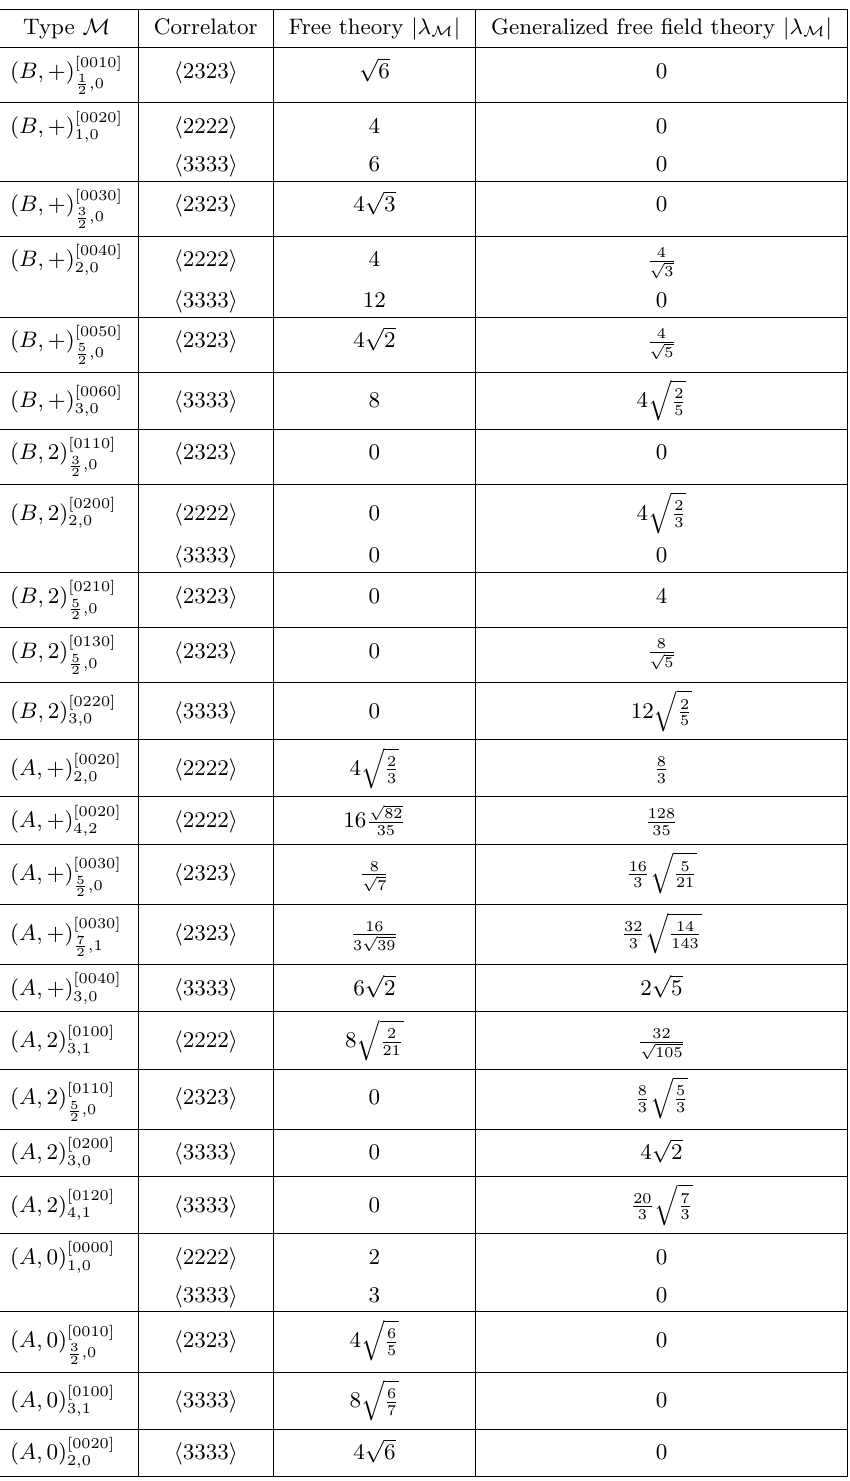
Table 4 . Values of OPE coe(cid:14)cients of the superconformal primaries of short multiplets and the lowest semishort and long multiplets of each type in correlators of S 2 and S 3 in the s -channel of the free and generalized free (cid:12)eld theory